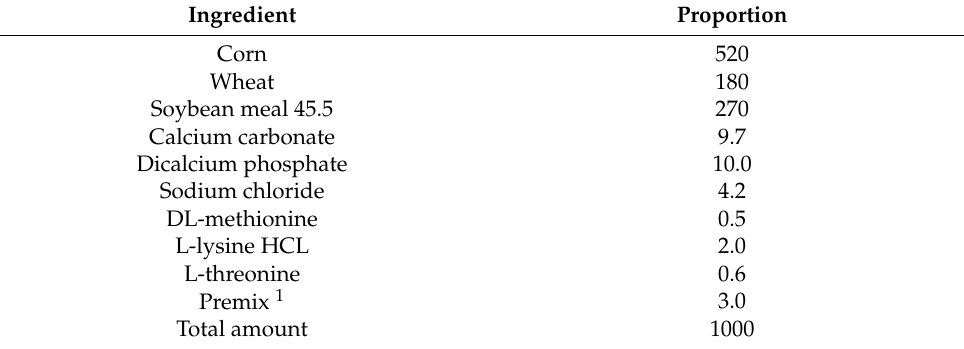
Table 2. Ingredients of the basal diet (g/kg).